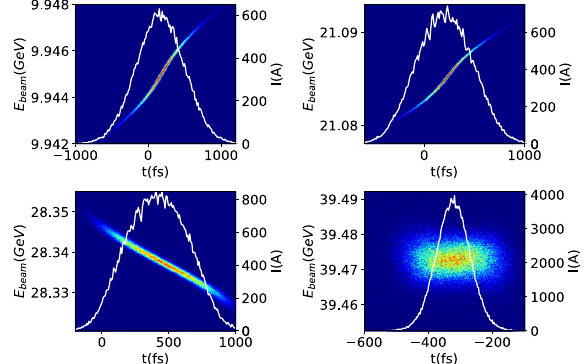
FIG. 4. Beam distribution in longitudinal phase space after passing through linac 1 (top left) linac 2 (top right), linac 3 (bottom left) and linac 4 (bottom right) for 40 GeV FEL operation, obtained by tracking with ELEGANT [37], including the linac wakefields from Ref. [29], and the shielded CSR impedance from CSRZ [24].